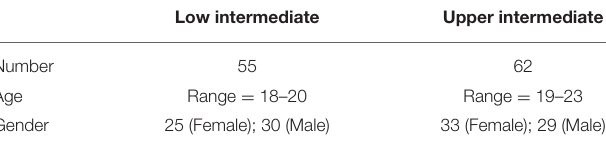
TABLE 2 | Participants’